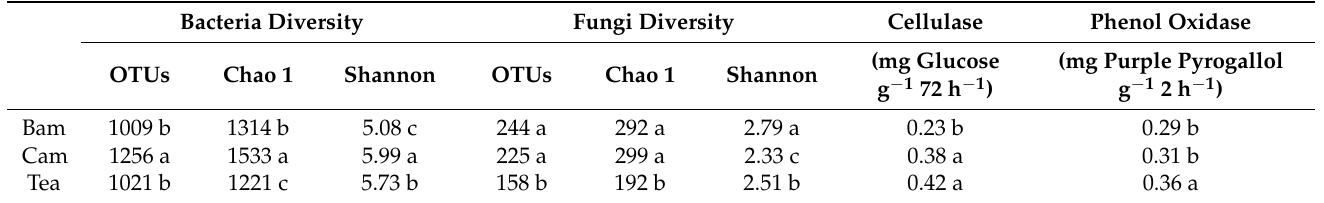
Table 4. Soil bacterial and fungal diversities and enzyme activities in bamboo (Bam), camphor (Cam), and tea (Tea)